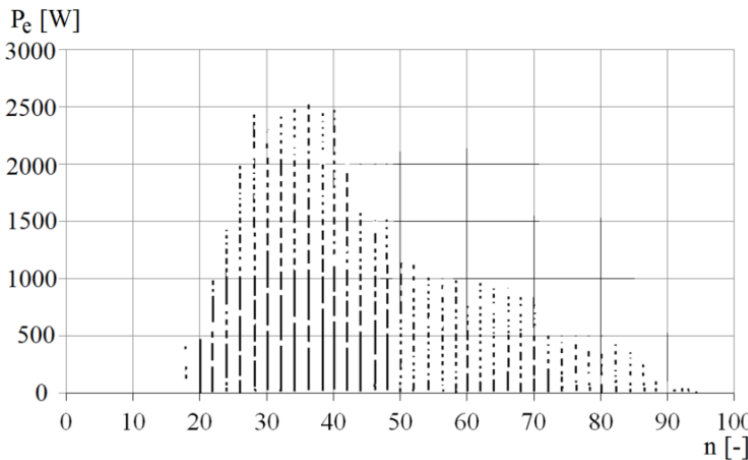
Figure 14. Dependence of the electric power P e on the number of blades n. Figure 14 . Dependence of the electric power P e on the number of blades n. Figure 14 . Dependence of the electric power P e on the number of blades n. Figure 14 . Dependence of the electric power P e on the number of blades n.